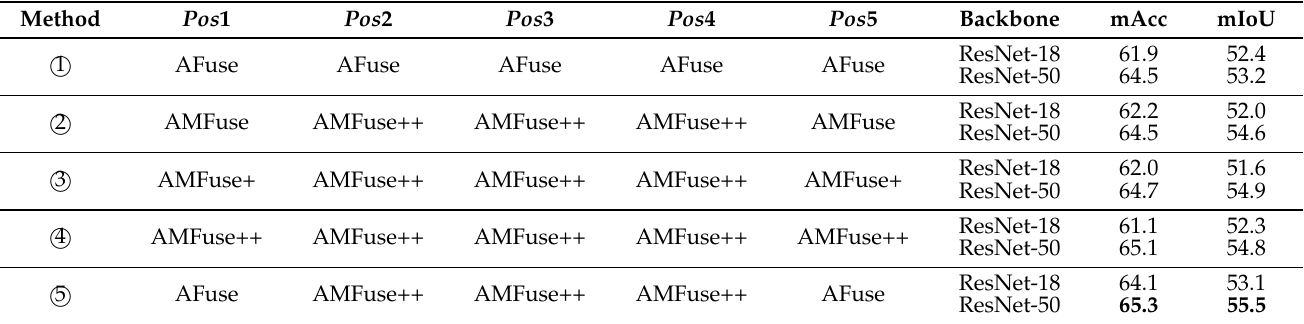
Table 4. The effectiveness of mixing AFuse and AMFuse++ modules (%).